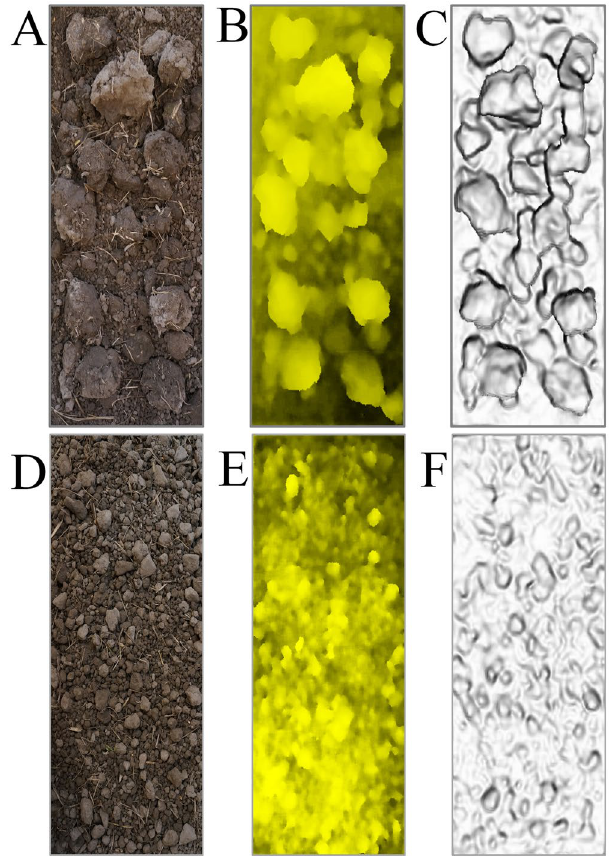
Figure 3. Preprocessing. ( A ) Color image of grade 6; ( B ) Depth image of grade 6; ( C ) Three-dimensional image of grade 6; ( D ) Color image of grade 3; ( E ) Depth image of grade 3; ( F ) Three-dimensional image of grade 3.